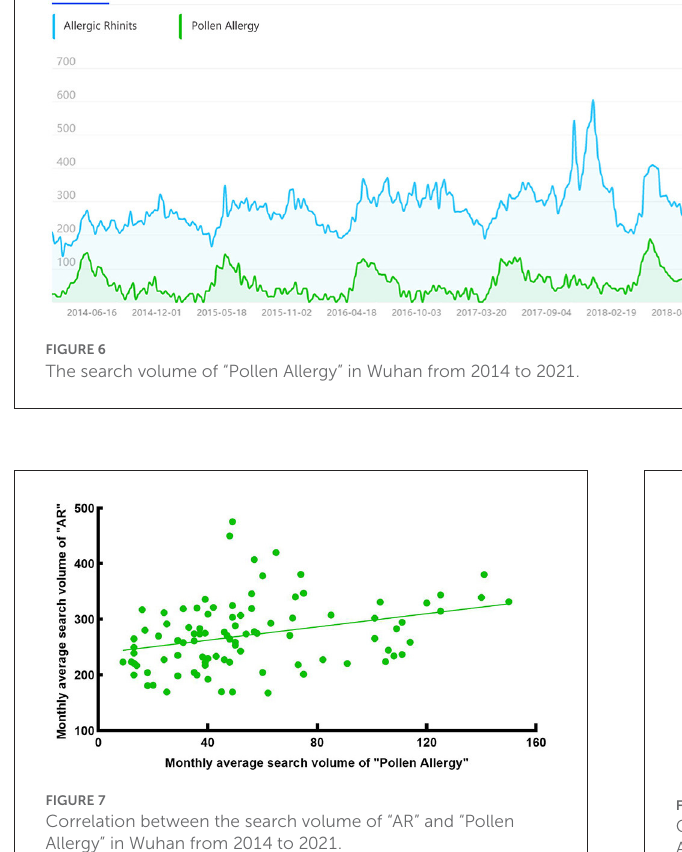
combined SV of the two keywords, and got a moderate positive correlation [R = 0.635, corrected P < 0.001, 95% CI: [0.501, 0.738], Figure